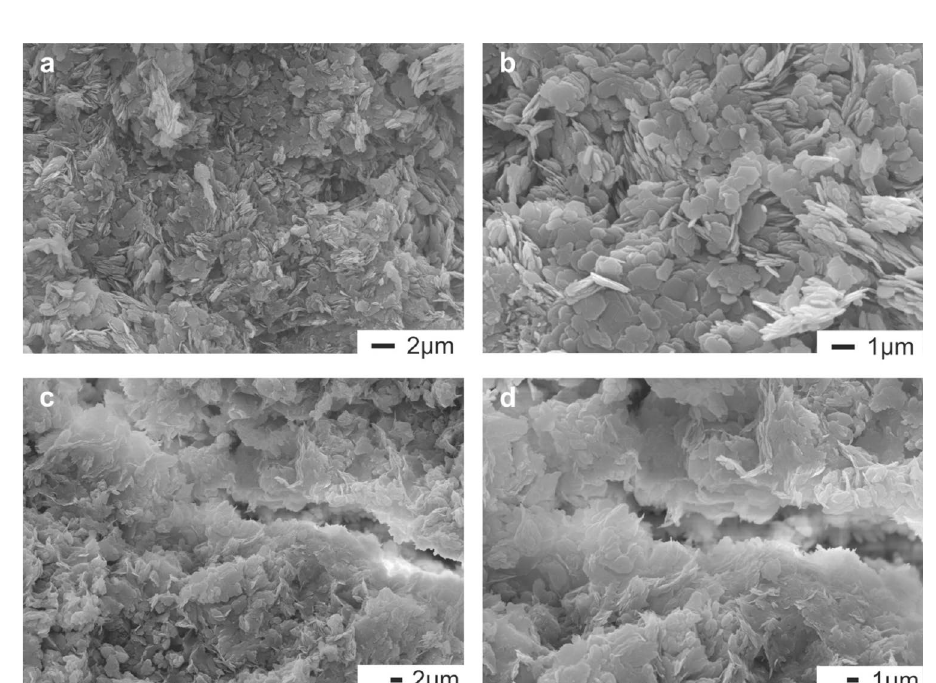
Figure 5. SEM images of clay mass of moderately heated Andosols in the Valley of Geysers: ( a ) Non-oriented clay matrix from moderately heated Andosols. ( b ) Pseudohexagonal crystals of kaolinite. ( c ) Open microcracks in clay matrix. ( d ) Microaggregates with sheet-like curved shape, composed of kaolinite and kaolinite-smectite particles, which form the walls of open